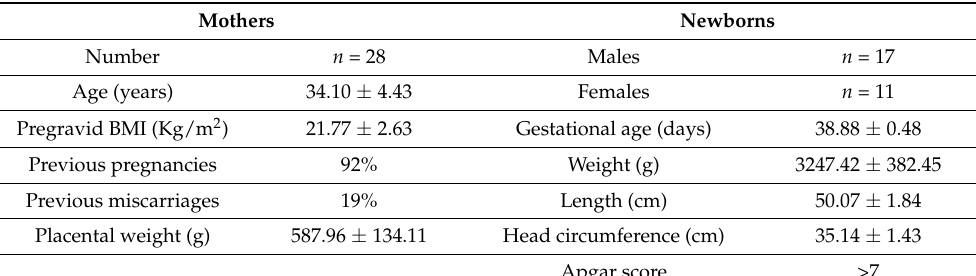
Table 1. Characteristics of the study